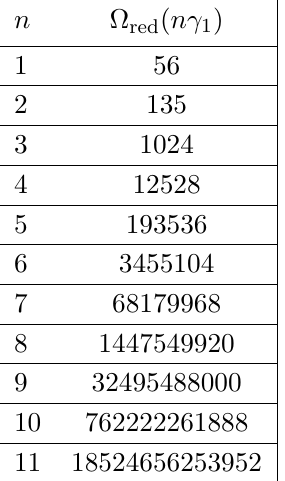
Table 2 . Numerical reduced indices for charges n(cid:13) 1 in the E 7 Minahan-Nemeschansky theory. p The discriminants both vanish at (17 + 12 2) (cid:0) 1 . Using the technique in [15] and